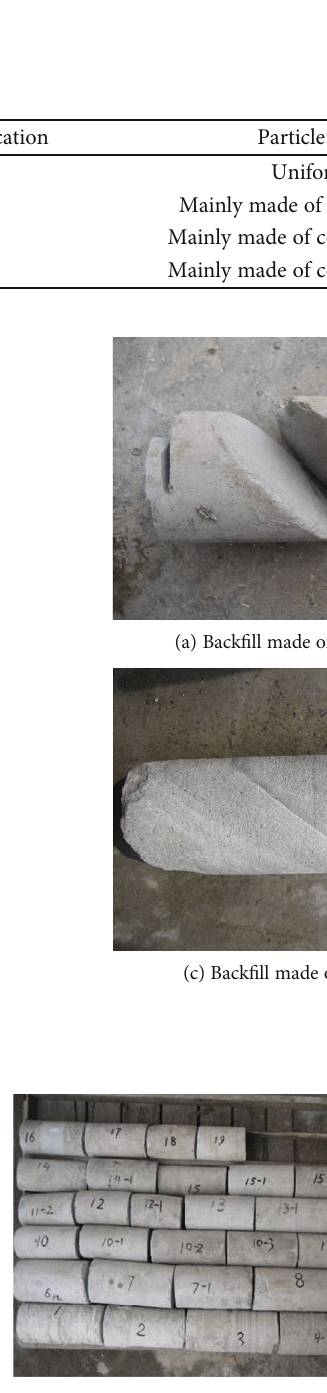
Figure 7: Samples for compression test. Figure 8: Samples for tensile